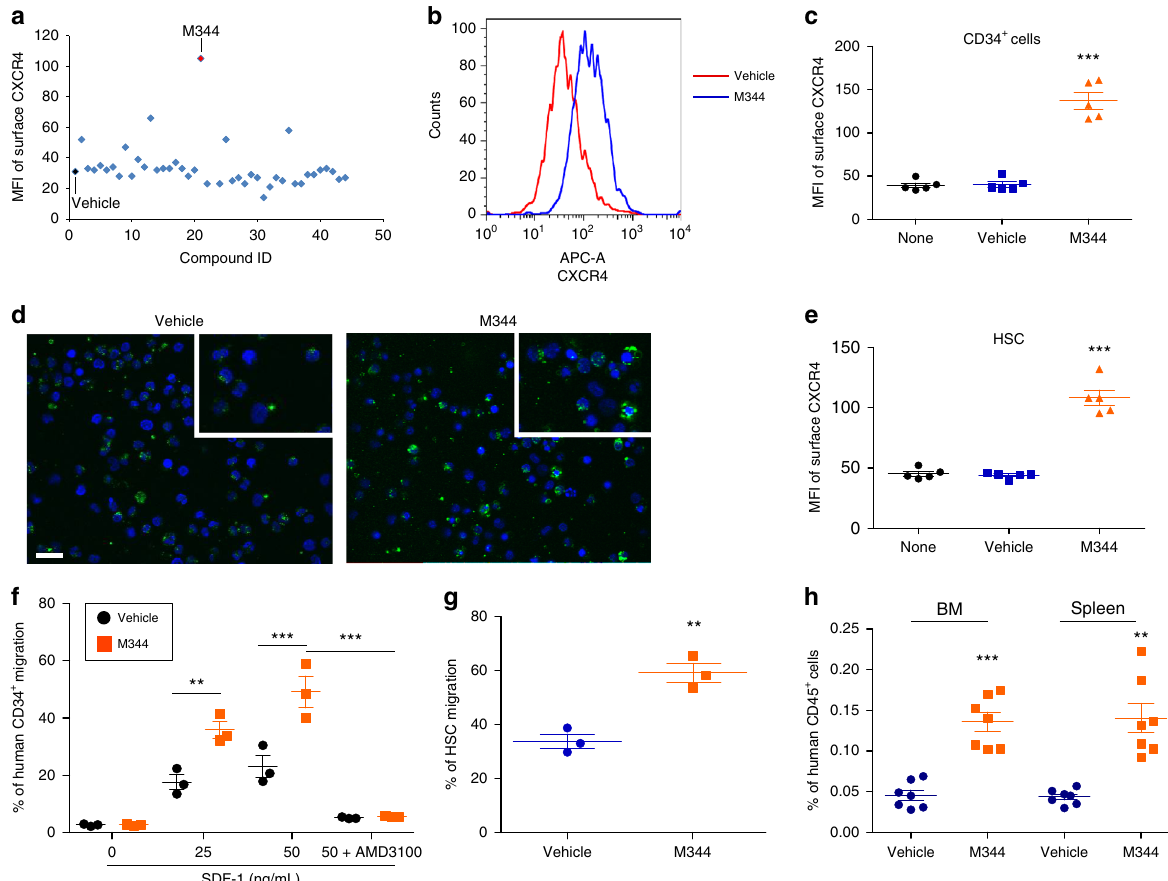
Fig. 1 Inhibition of HDAC upregulates surface CXCR4 expression and promotes homing of human hematopoietic stem and progenitor cells. a Mean fl uorescence intensity (MFI) of surface CXCR4 of human CB CD34 + cells after treating cells for 16 h with compounds (1 μ M) from the SCREEN-WELL Epigenetics Library. One compound, BML-266, was excluded from the results because of unspeci fi c auto fl uorescence. b Histogram of surface CXCR4 expression of human CB CD34 + cells treated with vehicle or HDAC inhibitor M344. Representative histogram from fi ve independent experiments is shown. c Quanti fi cation of mean fl uorescence intensity (MFI) of surface CXCR4 of human CB CD34 + cells treated with vehicle or HDAC inhibitor M344. None indicates the group without any treatment. Data pooled from fi ve independent experiments are shown ( n = 5, one-way ANOVA, *** p < 0.001). d Confocal imaging analysis of surface CXCR4 expression of human CB CD34 + cells treated with vehicle or M344. FITC (green) indicates CXCR4 expression; DAPI (blue) labels the cell nucleus. Representative images from two independent experiments are shown (the inset shows the ampli fi ed part of the image). Scale bar: 20 μ m. e Quanti fi cation of mean fl uorescence intensity (MFI) of surface CXCR4 of human CB HSCs (CD34 + CD38 − CD45RA − CD90 + CD49f + ) treated with vehicle or M344. None indicates the group without any treatment. Data pooled from fi ve independent experiments are shown ( n = 5, one-way ANOVA, *** p < 0.001). f Chemotaxis of human CB CD34 + cells toward human recombinant SDF-1, as quanti fi ed by fl ow cytometry. Data pooled from three independent experiments are shown (each dot represents an independent chemotaxis, n = 3 CB samples, one-way ANOVA, ** p < 0.01,